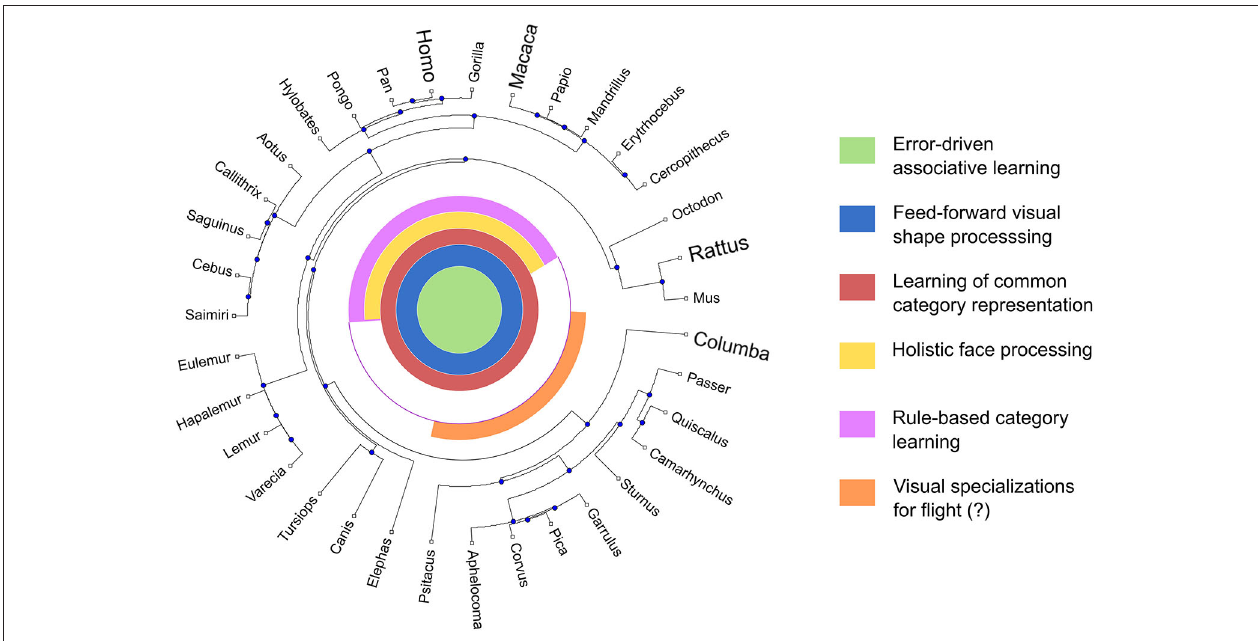
circles at the center represent different hypothesized computational mechanisms. If a line is drawn from a particular leaf to the center of the diagram, then the colors intersected by the line represent those mechanisms hypothesized to be present in that particular